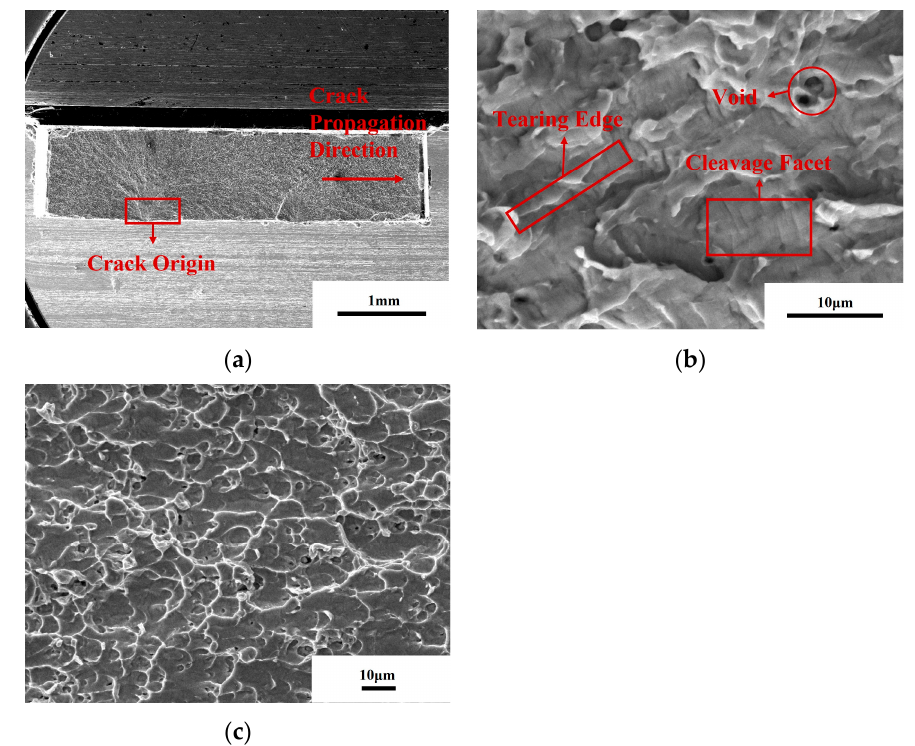
Figure 12. Fracture morphology after tensile test of alloy annealed at 600 °C for 60 min. ( a ) Low magni fi cation morphology of fracture area; ( b ) crack propagation area; and ( c ) dimple region.